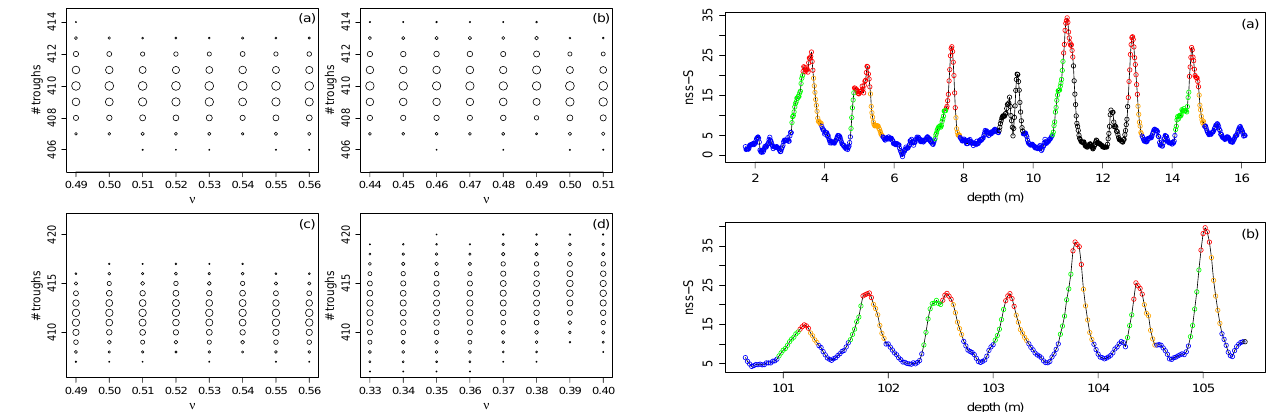
Fig. 12. Two portions of the classified log nss-S signal from the Gomez ice-core for ν 1 = 0 . 85, ν 2 = 0 . 5, and β = 10. Points within an issue are black, points within peaks coloured red, descending points orange, troughs blue, and ascending points green. (a) At the start of the core. (b) Towards the end of the